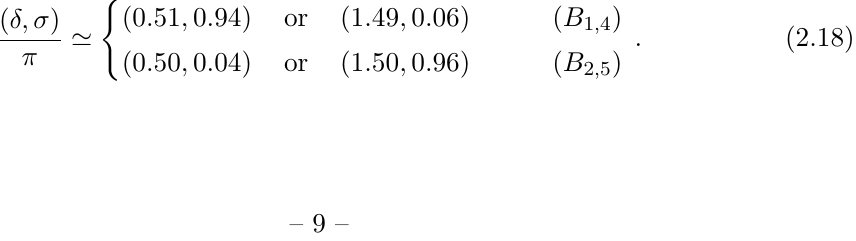
table 1. With the aid of the best-(cid:12)t values for (cid:14)m 2 , (cid:1) m 2 , sin 2 (cid:18) we then (cid:12)nd the following predictions for the phases (cid:14) and (cid:27) in models with an exact two-zero